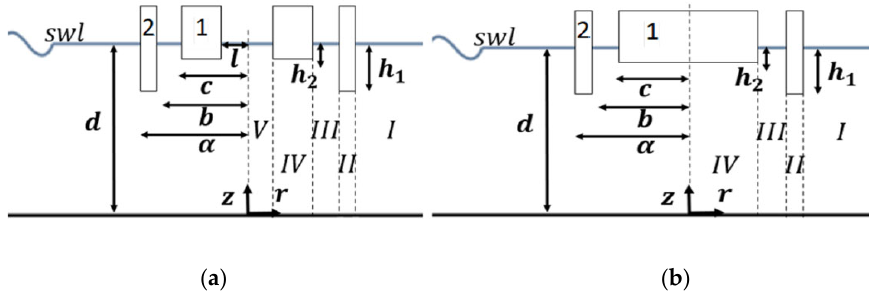
Figure 2. Schematic representation of the two moonpool-type case studies: ( a ) floater of two coaxial, free-surface piercing moonpool cylinders with vertical symmetry axes; ( b ) floater of an external toroidal cylinder and an internal coaxial truncated cylinder .